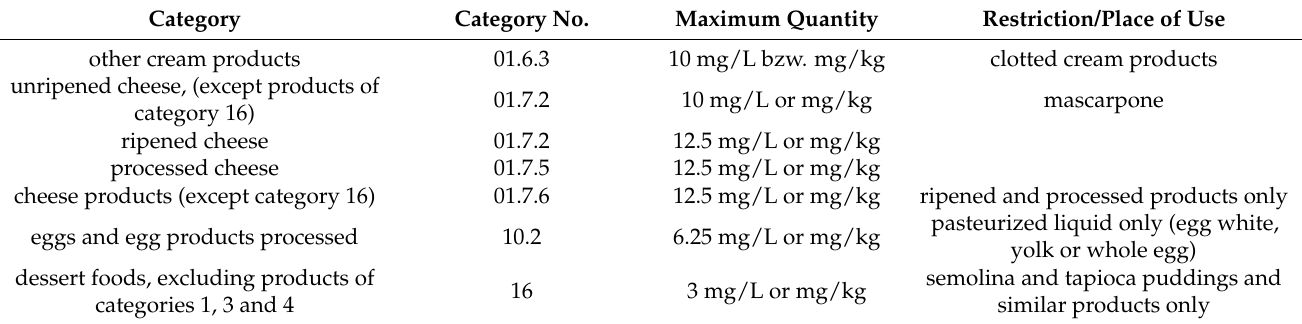
Table 2. Allowed addition of nisin in food, natural occurrence in the products not included, source Regulation (EC)